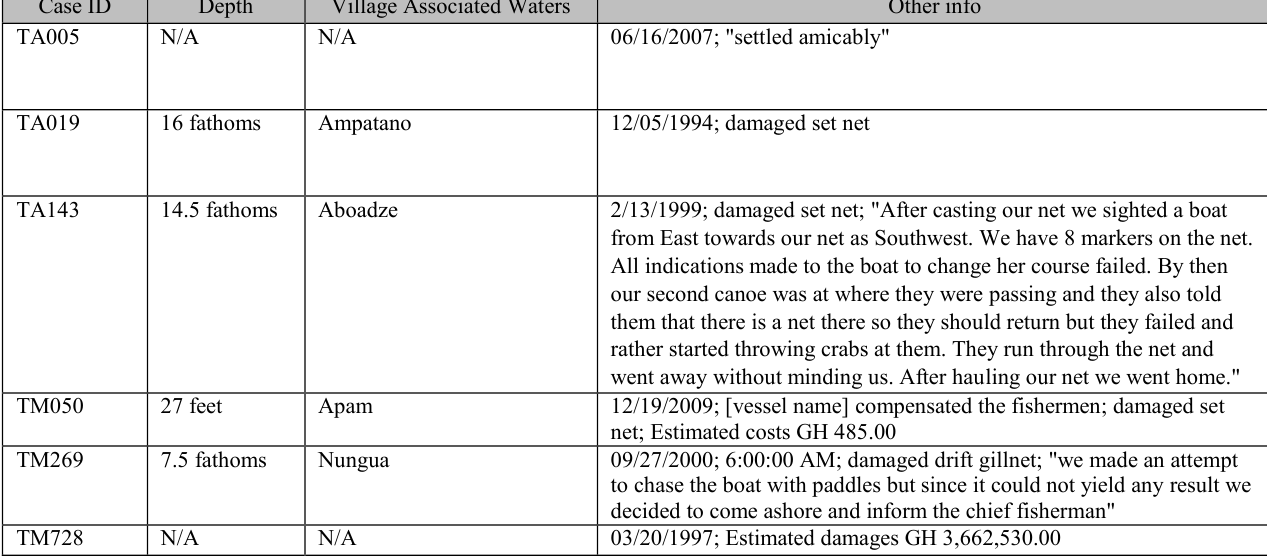
Table A1.2 : Sample of information included in records of conflicts between small-scale and industrial vessels in Ghana, as documented in reports.